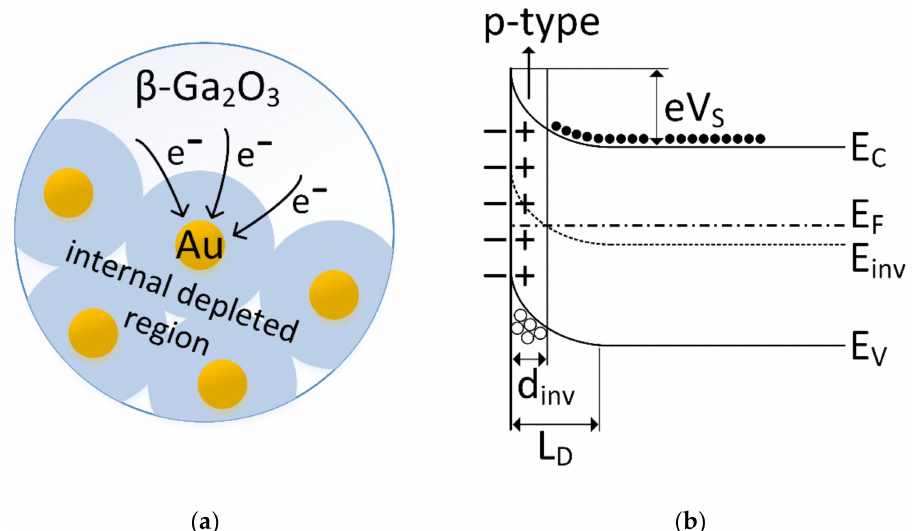
Figure 15. ( a ) Internal depleted layer at the β -Ga 2 O 3 /Au phase boundary; ( b ) corresponding band diagram; E inv —energy of the inversion level, E F —energy of the Fermi level, E C —energy of the lower edge of the conduction band, E V —energy of the upper edge of the valence band, L D —width of the depleted layer, d inv —width of the inversion layer, —holes, • —electrons, e V S —height of the (cid:35) potential barrier at the surface of the